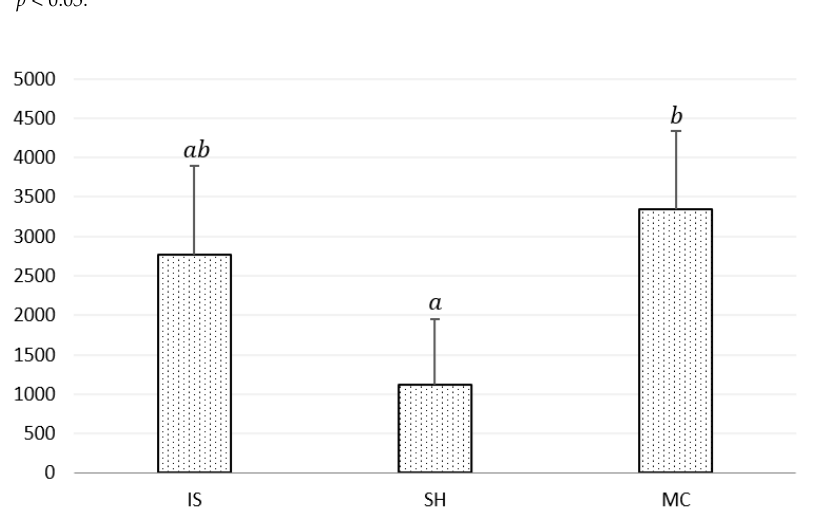
Figure 1. Mean HF with regard to paddock conditions: IS—insolated, SH—shaded, MC—under mist curtain. Vertical lines show the standard deviation. Means marked with different letters significantly differ at p < 0.05; the same letters indicate that significant differences do not appear. Table 4. The influence of experimental conditions on behavioural parameters: Friedman test proba- bility